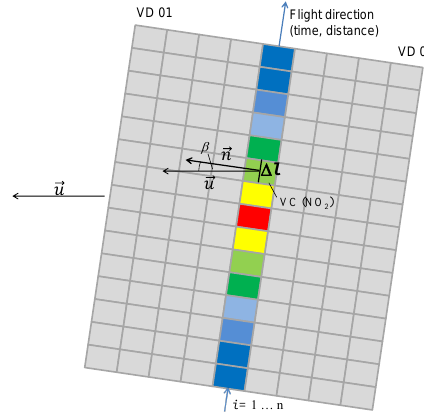
Figure 16. Sketch illustrating the emission flux calculation from AirMAP data for an example plume overpass with wind vector u , line element (cid:49)l , flight path normal vector n , angle β and NO 2 ver- tical column VC(NO 2 ). The contributions i to the emission source strength Q (Eq. 11) are summed up along the